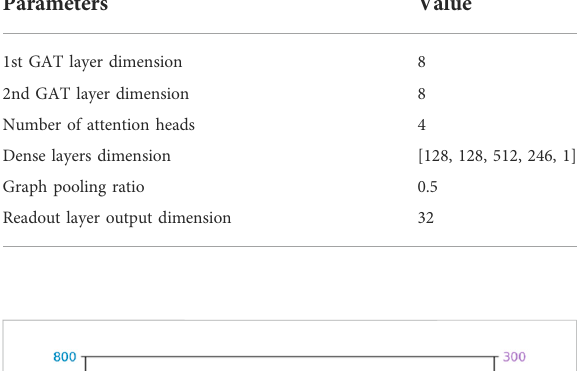
TABLE 1 The details of the pke-rl agent.